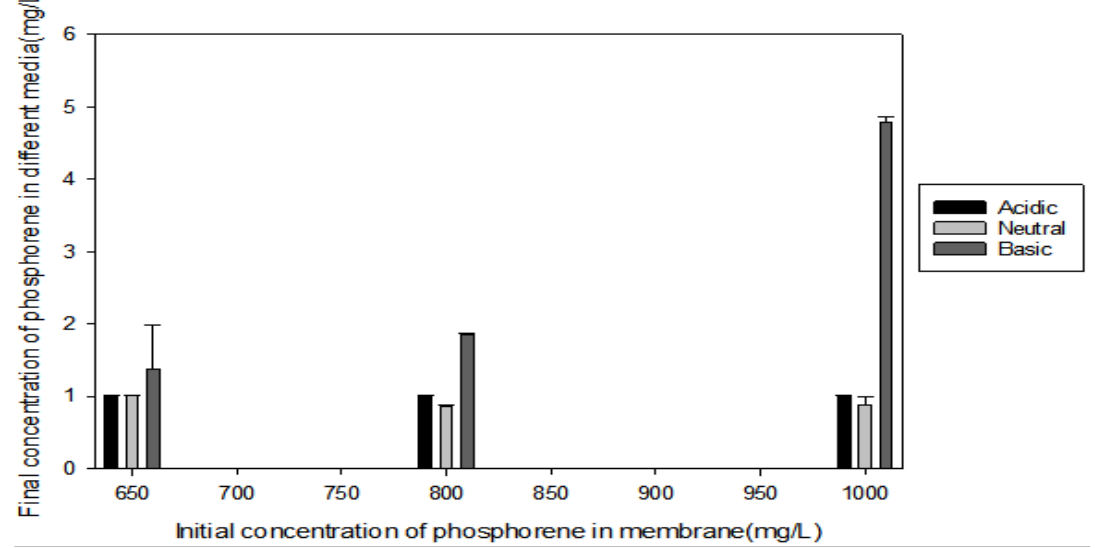
Figure 10. Leaching experiment of phosphorene in membranes .